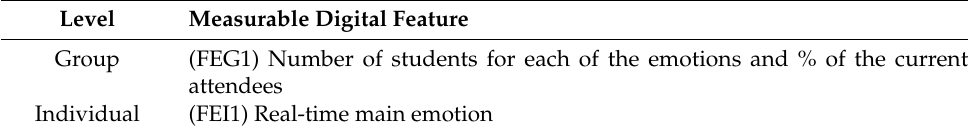
Table 13. Set of digital features defined for “facial emotion” category, corresponding to the features E10.